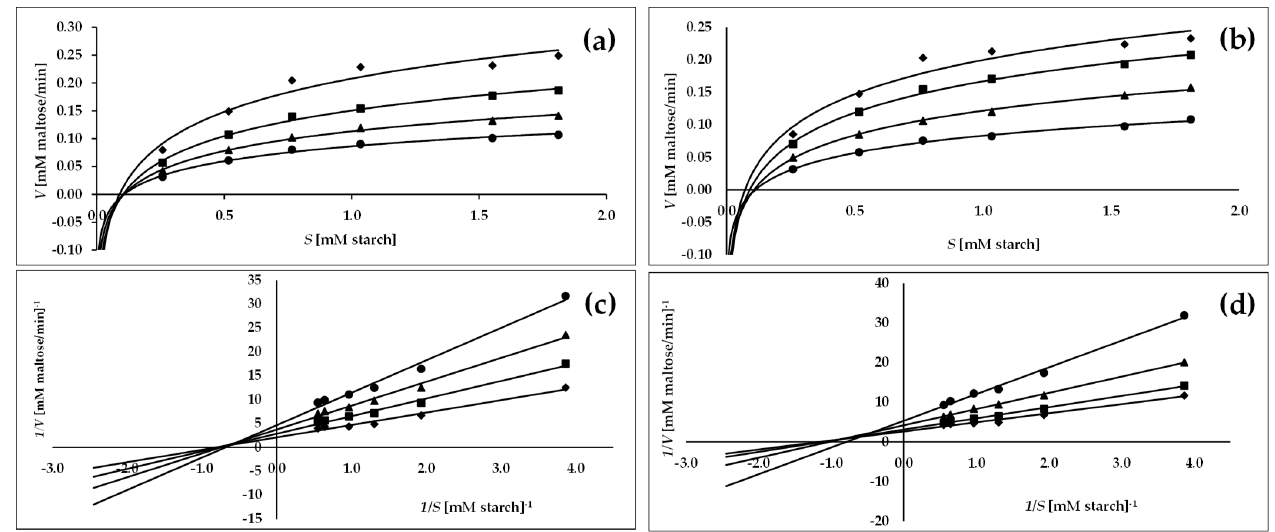
Figure 3. Michaelis–Menten plots ( a , b ) and Lineweaver–Burk plots ( c , d ) of methanol–water (7:3, v/v ) extract of C. bullatus leaves MBL ( a , c ) and acarbose ( b , d ) for inhibition of α -amylase; the MBL concentrations: ♦ —control (no inhibitor), —20.0 µg/mL, —40.0 µg/mL, • —10.0 µg/mL and acarbose ( b , d ) with concentrations: ♦ —control (no inhibitor), —3.0 µg/mL, —8.0 µg/mL, • —10.0 µg/mL). Table 3. Kinetic parameters of α -amylase and α -glucosidase in the presence of C. bullatus leaf extract and acarbose.